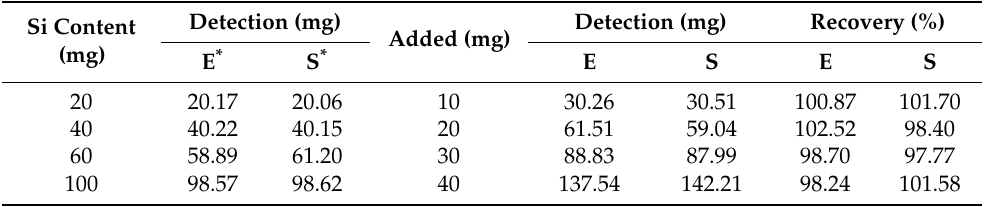
Table 1. Comparison of proposed electrochemical sensor with silicon-molybdenum blue spectropho- tometric analysis.